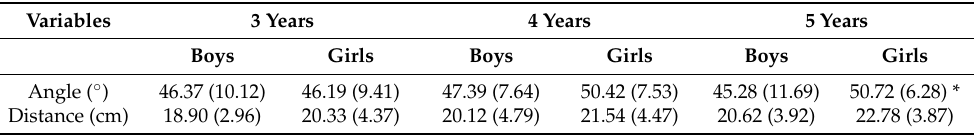
Table 4. Two-way ANOVA results of MSR angle scores and MSR distance scores for age and gender